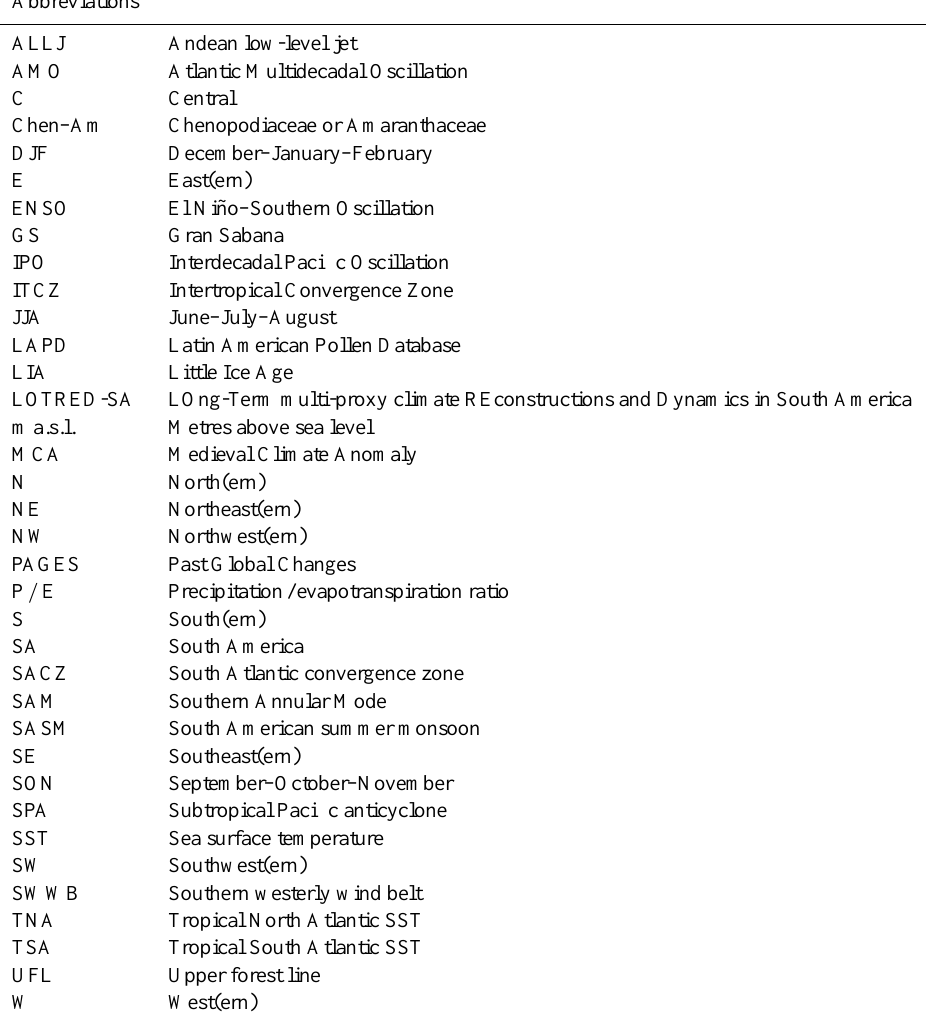
Table 4. List of